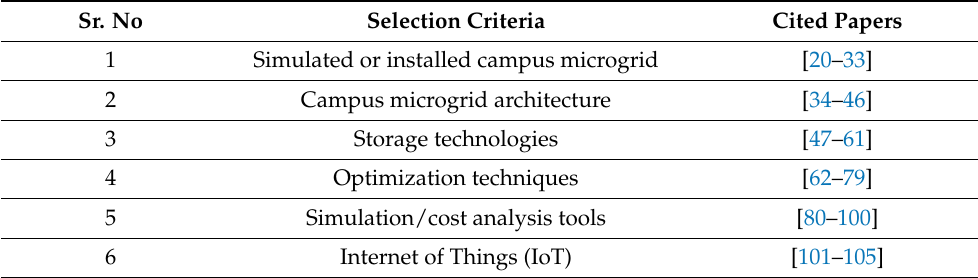
Table 1. Criteria table of selected